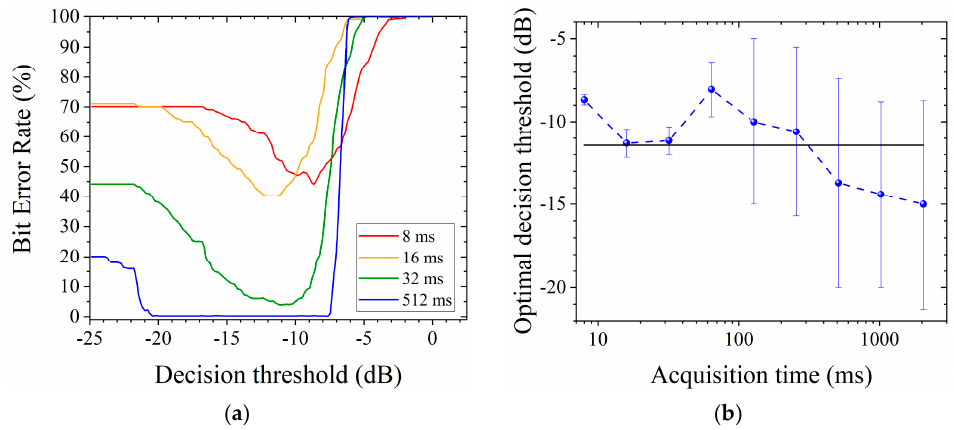
Figure 7. ( a ) BER versus the value of decision threshold, computed from different acquisition times. ( b ) Evolution of the decision threshold in function of the acquisition time for minimum BER (blue curve), and optimal decision threshold calculated from (black line).